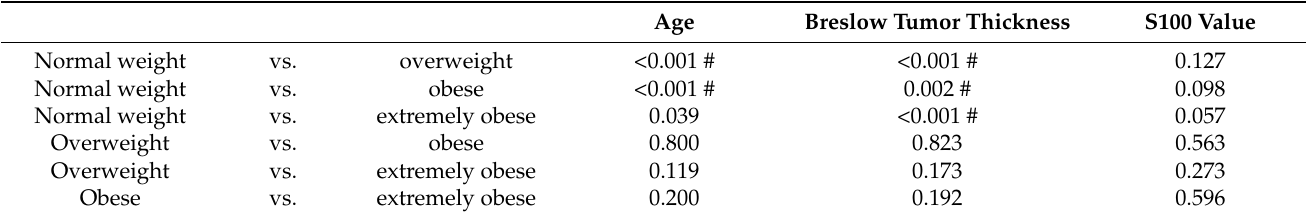
Table 3. p -values of the pairwise comparisons of the BMI groups (Mann–Whitney U test).